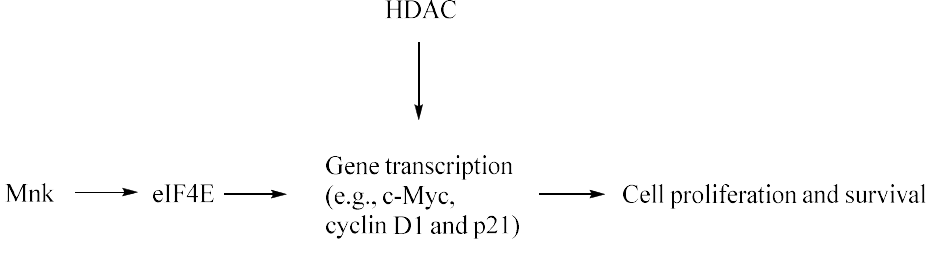
Figure 2. The interaction between HDAC and Mnk in tumor cells.